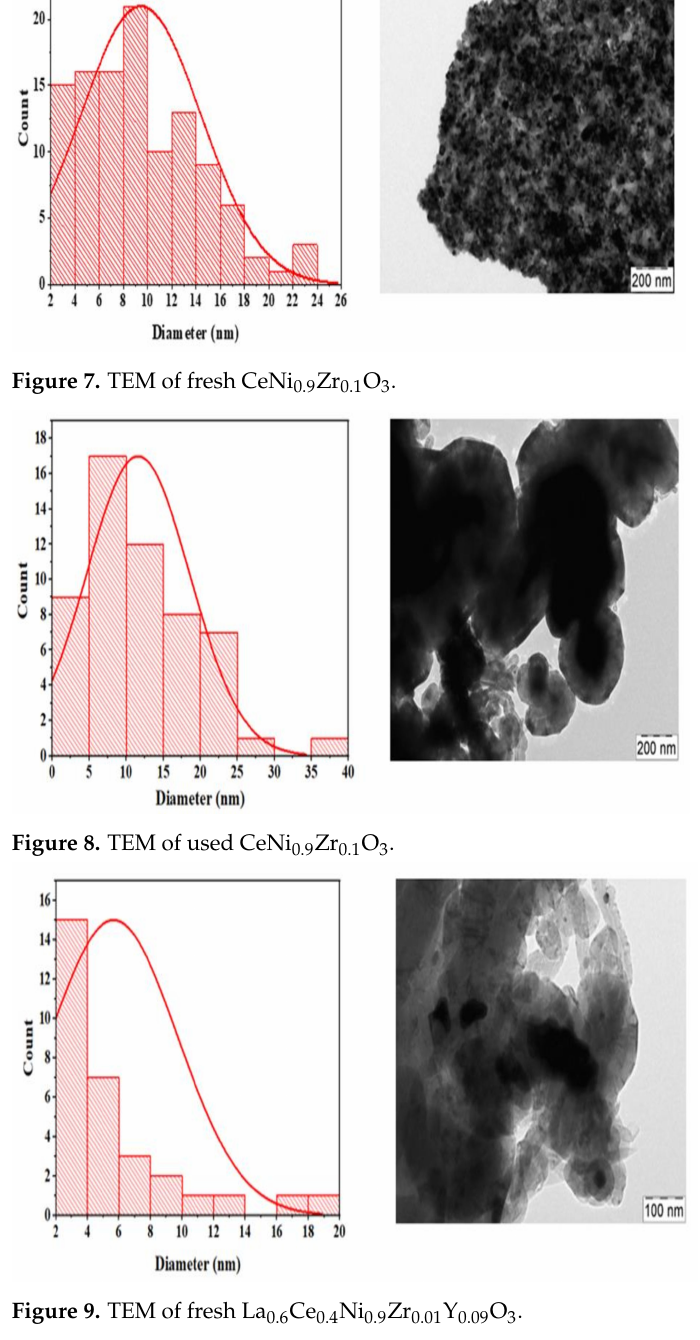
Figure 9. TEM of fresh La 0.6 Ce 0.4 Ni 0.9 Zr 0.01 Y 0.09 O 3